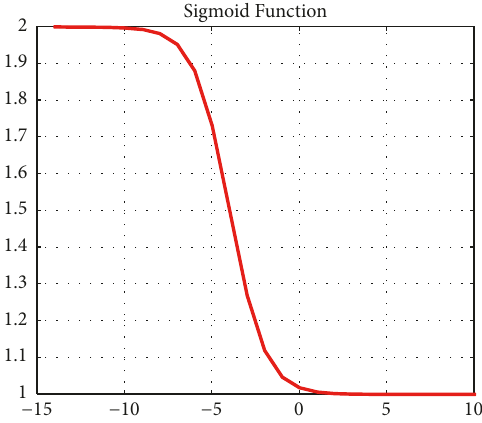
Figure 1: The weight function for weight matrix 𝑄